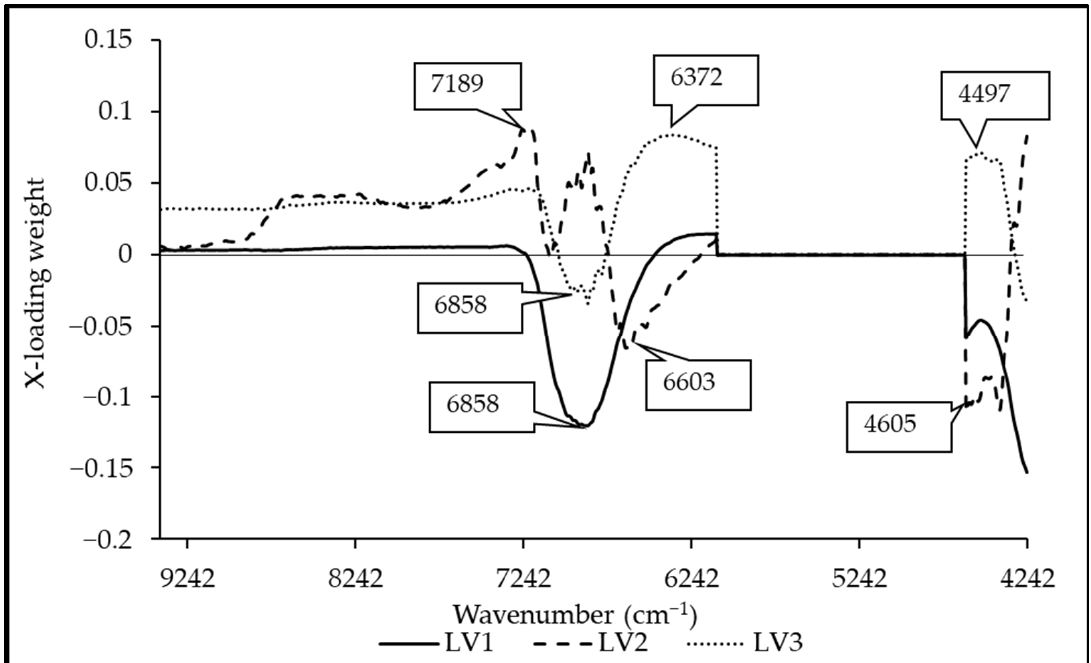
Figure 9. X ‐ loading plot of the PLSR model for TSS in mangosteen purée. Table 8. The bands with a high regression coefficient of the PLSR model for TSS in mango purée. Wavenumber